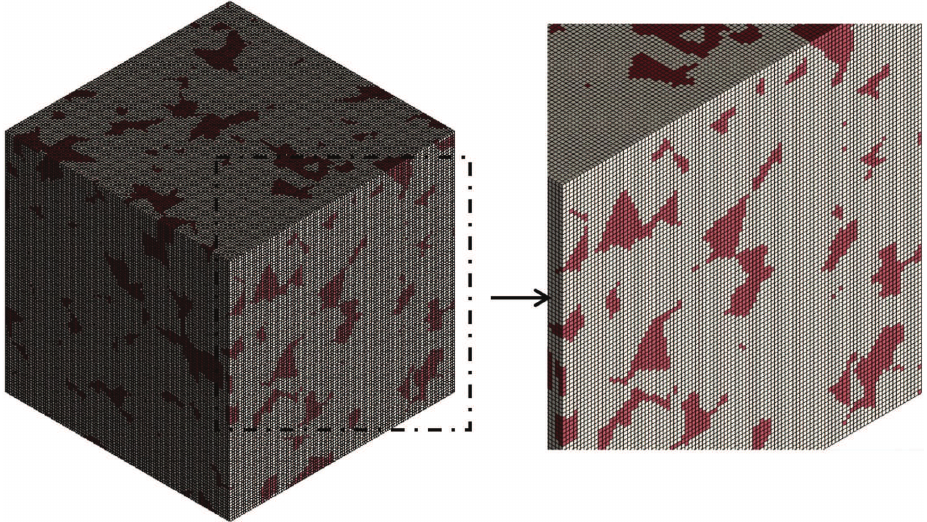
Figure 10: Finite element discretization of three-dimensional microgeometry including cobalt islands.